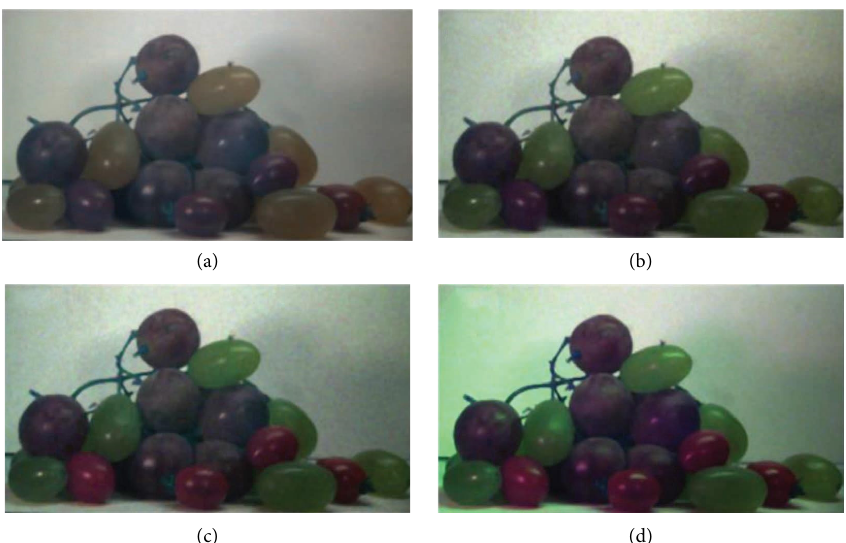
Figure 12: Image color recovery and fruits contrast enhancement. (a) Artifcial color image using CIE curve. (b) False color with reference wavelengths of 607, 533, and 482nm. (c) False color with reference wavelengths of 629, 533, and 482nm. (d) False color with reference wavelengths of 629, 546, and 482nm.